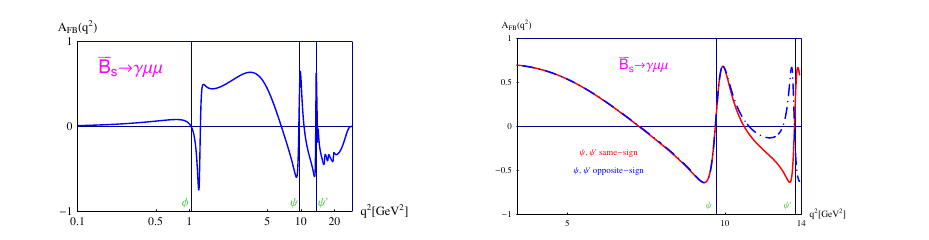
γµ + µ − decay. The right plot shows the asymmetry →